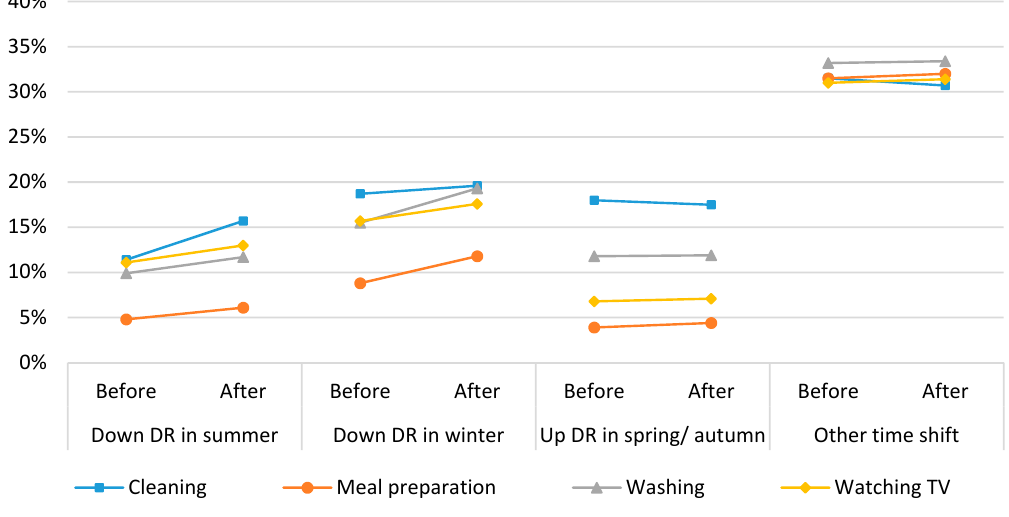
Figure 4. Proportion of respondents who responded to a request for each DR (proportion of all respondents who usually perform each activity).